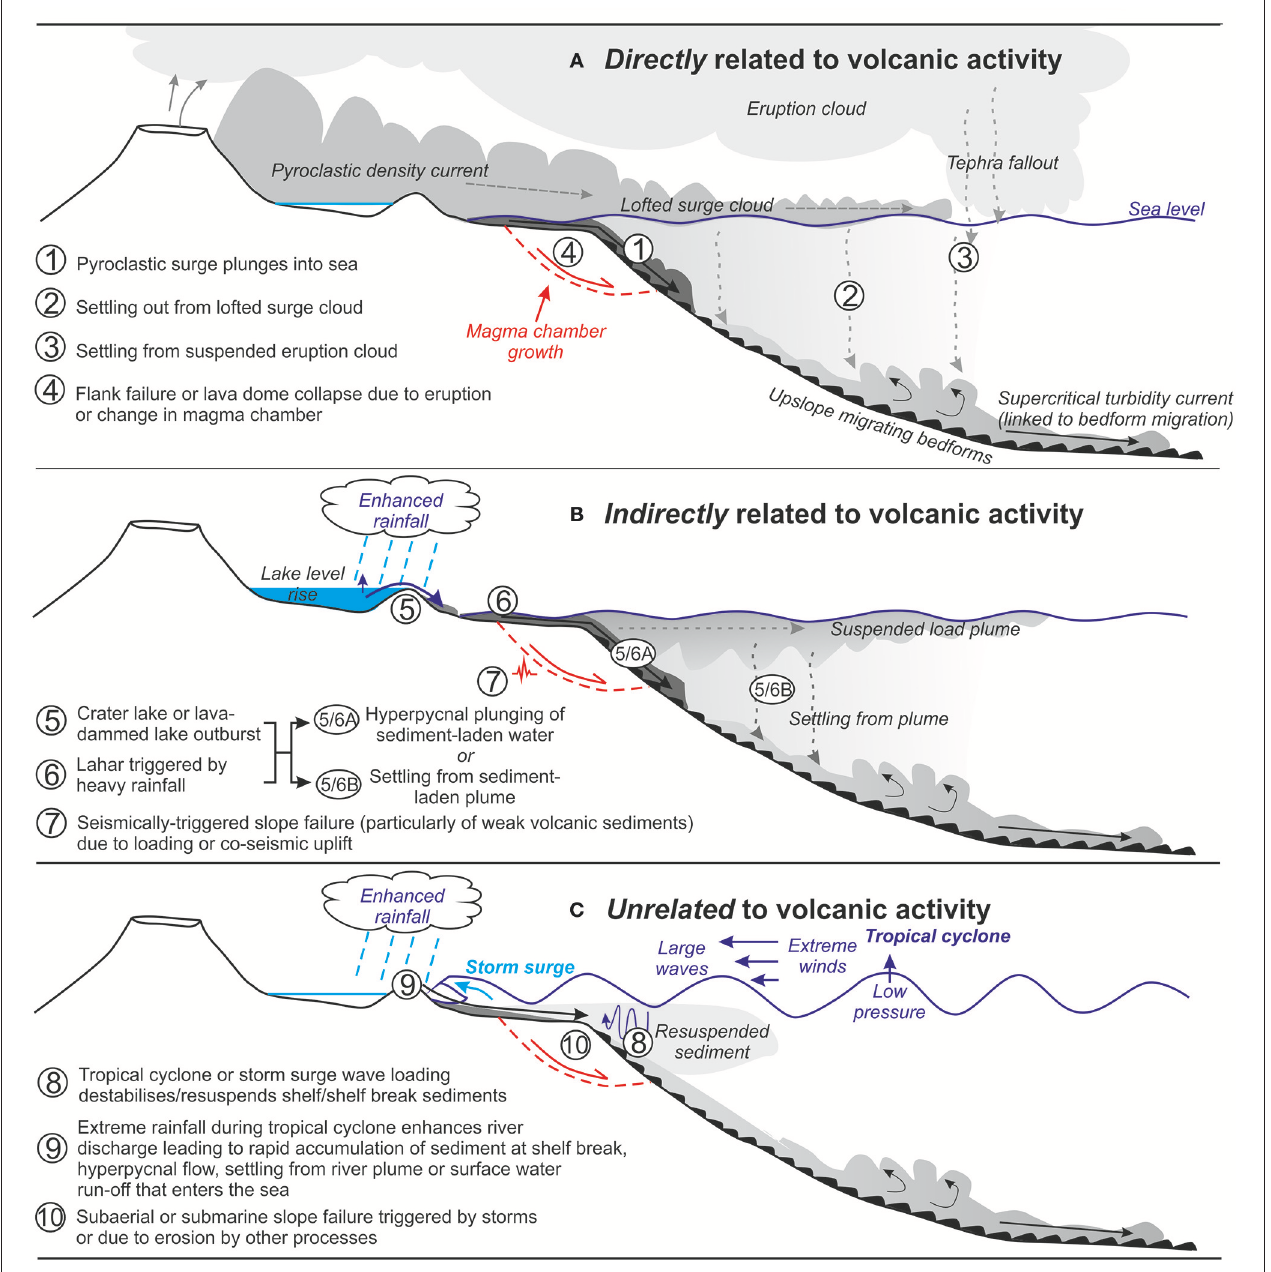
FIGURE 12 | General model of processes that contribute to preconditioning or drive triggering of submarine slope failures and turbidity currents at volcanic islands, related directly (A) , indirectly (B) and unrelated to volcanic processes. Unlike in Figure 10 , the numbering here is not sequential and simply refers to isolated